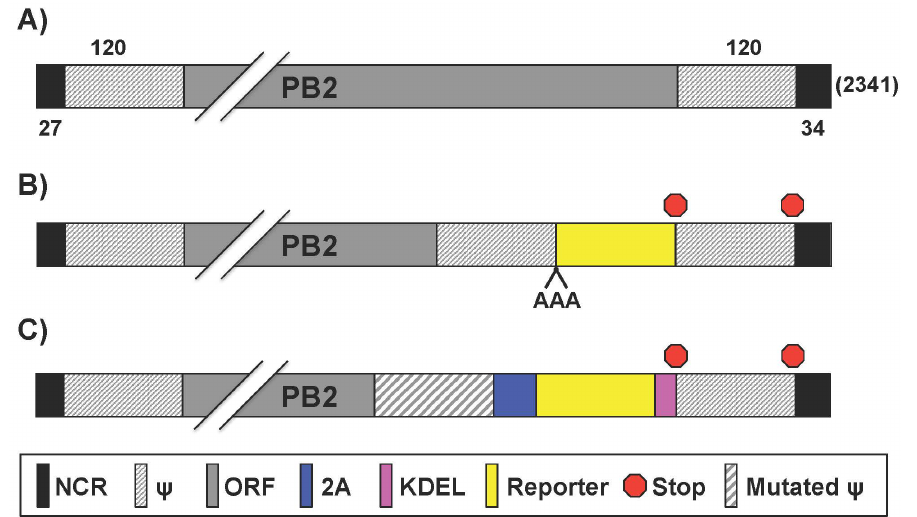
Figure 2. PB2 reporter influenza A viruses: Schematic representation of the PB2 segment from wild type (WT) ( A ) and reporter ( B , C ) IAV. Gene segments all contain non-coding regions (NCR), packaging signals ( ψ ) and open reading frames (ORF) for gene replication/transcription, virion incorporation, and protein expression, respectively. Nucleotide lengths for the NCR, ψ , and PB2 segment are indicated; ( B ) PB2 fusion proteins: Reporter genes were fused to native PB2 ORF with a triple alanine (AAA) spacer; ( C ) Bicistronic transcription of PB2 and reporter gene: Insertion of the 2A autocleavage site separates PB2 from reporter gene. Packaging signals encoding the 3’ terminus of PB2 were mutated to minimize interference with native ψ , which are duplicated at the 3’ NCR-proximal region. KDEL (lysine-aspartic acid-glutamic acid-leucine) signal sequence was inserted for endoplasmic reticulum-retention of the reporter gene. Packaging signals were duplicated after protein stop transcription signal and before the 3’ NCR